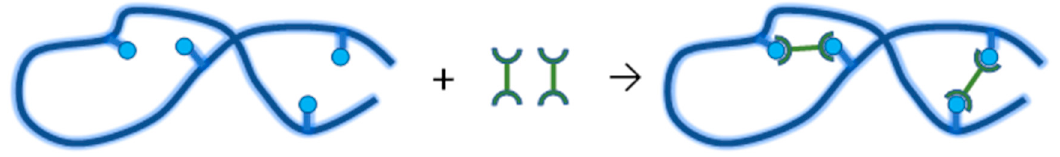
Figure 14. Intermolecular crosslinking of a macromolecule using a chemical cross-linking agent. For details see e.g. [259].